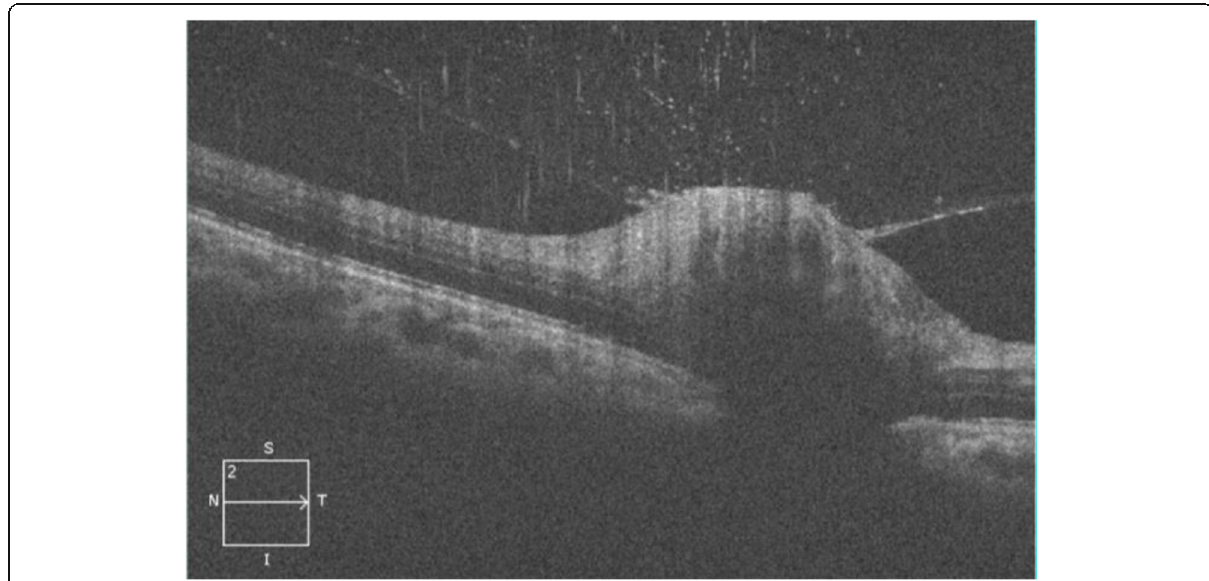
Fig. 5 Patient no. 12. SD-OCT of the left eye: swollen ONH with overlying vitritis and incomplete posterior vitreous detachment (PVD). No SRF or macula star developed in this patient. The ONH oedema and vitritis resolve following